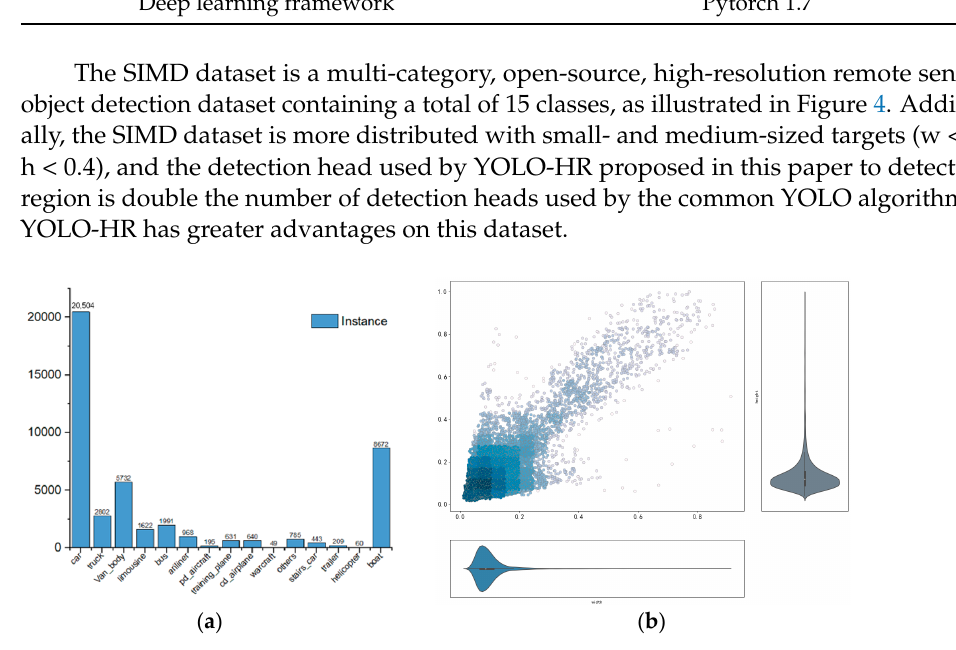
Figure 4. Distribution of targets in SIMD dataset. ( a ) shows the distribution of the number of categories; ( b ) shows the distribution of target width and height in the image; the color from white to blue (from light to dark) indicates a more concentrated distribution.